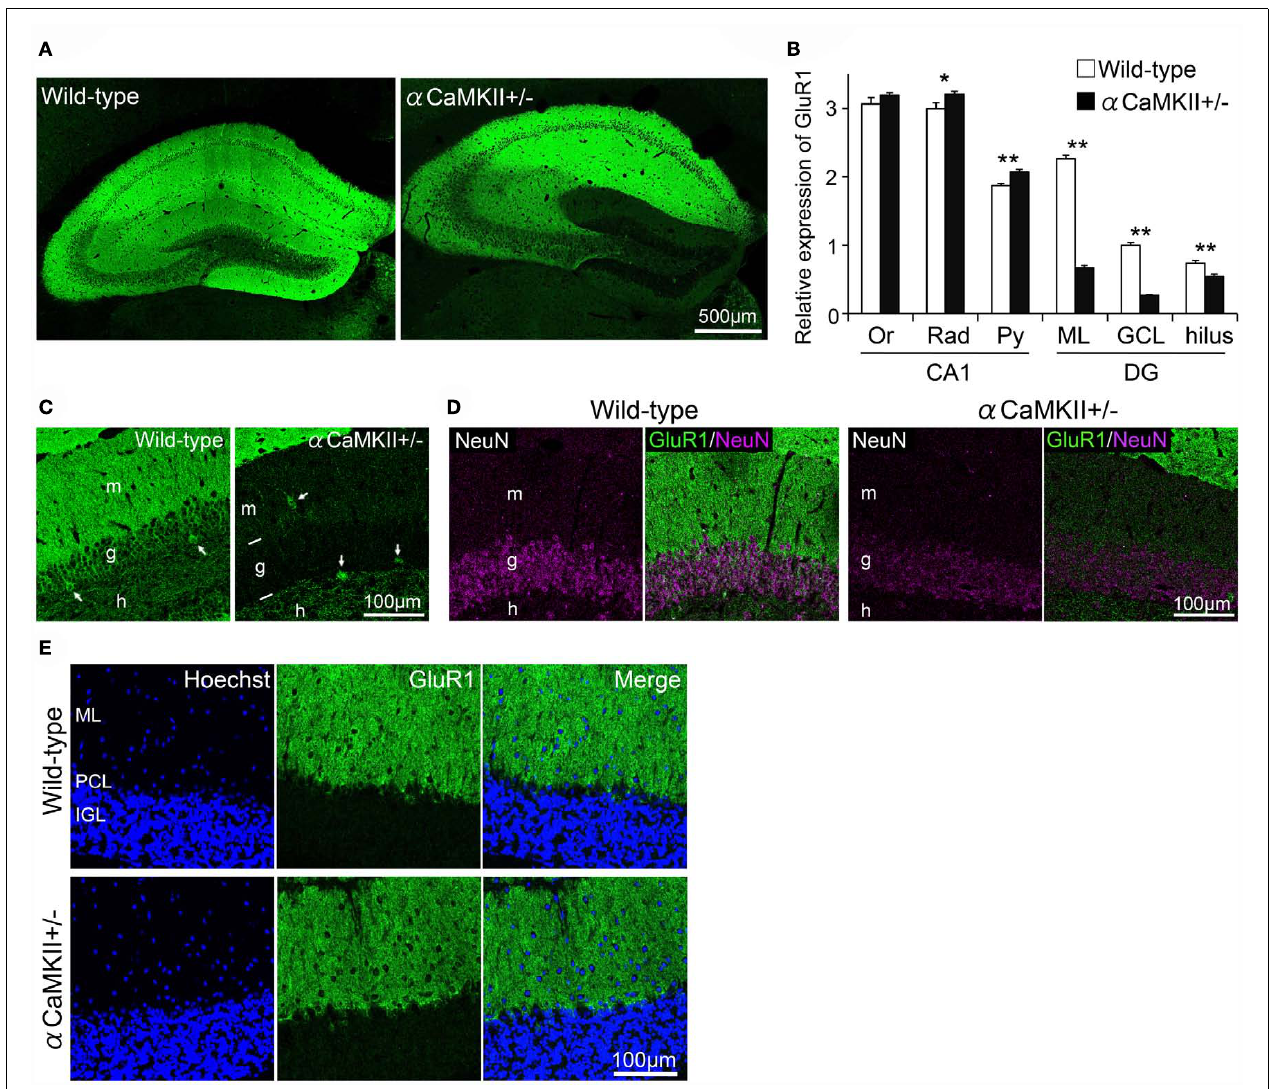
mutants. As a result of reduced GluR1 expression in the granule cells in the mutants, GluR1-positive interneurons located in the dentate gyrus were clearly visualized (arrows). (D) Expression level of neuron-specific protein NeuN was diminished in the granule cells of the mutants. (E) Parasagittal sections of adult α CaMKII ± mice cerebellum were stained with GluR1 antibody. Immunoreactivity for GluR1 in Bergmann glial cells was hardly affected in the mutant mice. DG, dentate gyrus; GCL, granule cell layer; IGL, internal granule cell layer; ML, molecular layer; Or, oriens layer; PCL, Purkinje cell layer; Py, pyramidal cell layer; Rad, radiatum